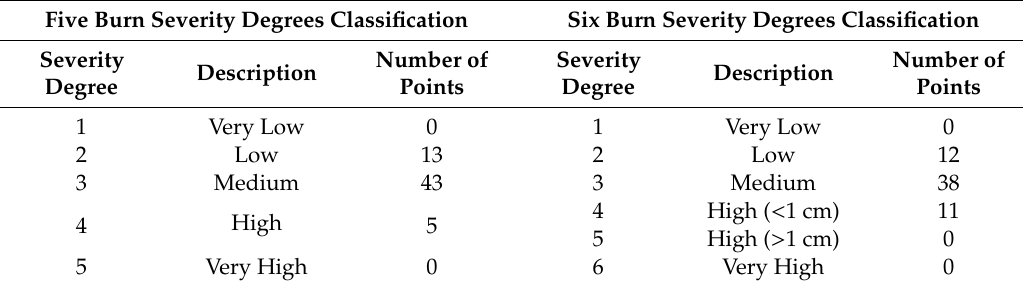
Table 2. Burn severity measured in situ classifications.